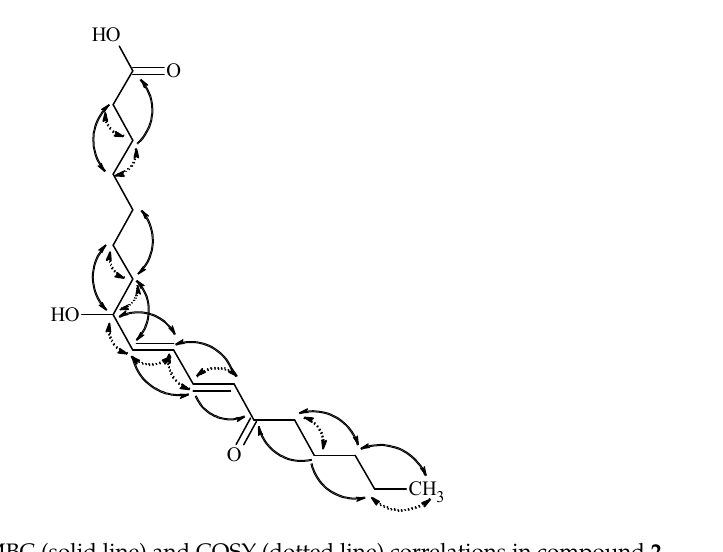
Figure 4. Key HMBC (solid line) and COSY (dotted line) correlations in compound 2.